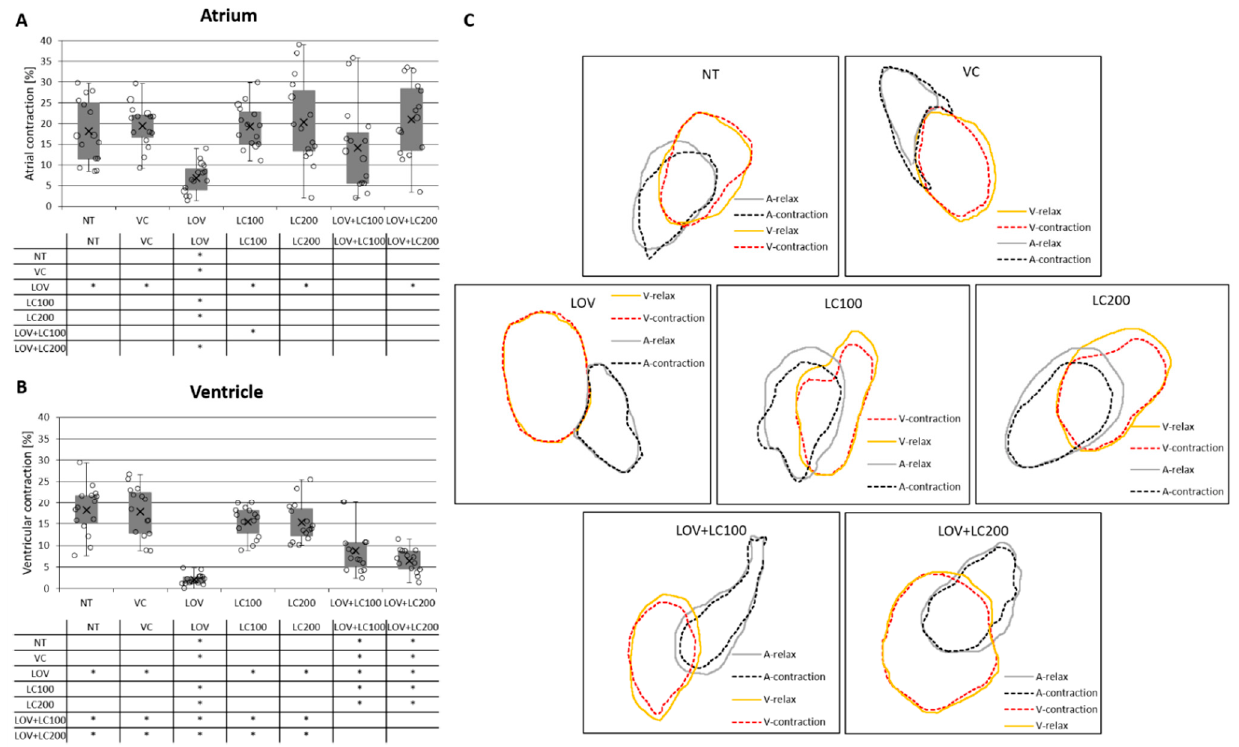
Figure 6. Analysis of heart contraction in 120 hpf zebrafish larvae exposed to lovastatin (LOV) and L ‐ carnitine (LC) treatment. Atrial contraction expressed as the percentage difference between the atrial surface in systolic and relaxed states. Ventricular contraction expressed as the percentage difference between the ventricular surface in systolic and relaxed states. Bar graphs illustrate measurements of the atrial ( A ) and ventricular ( B ) contraction of zebrafish larva heart in control (non ‐ treated, NT; vehicle control, VC; 100 μ M L ‐ carnitine, LC100; 200 μ M L ‐ carnitine, LC200) and experimental (0.5 μ M lovastatin, LOV; 0.5 μ M lovastatin and 100 μ M L ‐ carnitine, LOV+LC100; 0.5 μ M lovastatin and 200 μ M L ‐ carnitine LOV+LC200) groups. The tables below indicate the pairwise comparison between atrial ( A ) and ventricular ( B ) contraction of seven investigated groups. Statistically significant differences are indicated with *; * p < 0.05 Kruskal–Wallis test followed by pairwise Mann–Whitney post ‐ hoc tests); 5 individuals in each investigated group. Error bars show the standard deviation. ( C ) Exemplary graphs show the systolic and diastolic heart outlines of seven investigated groups used for calculations. Orange line represents ventricle relaxation (ventricular